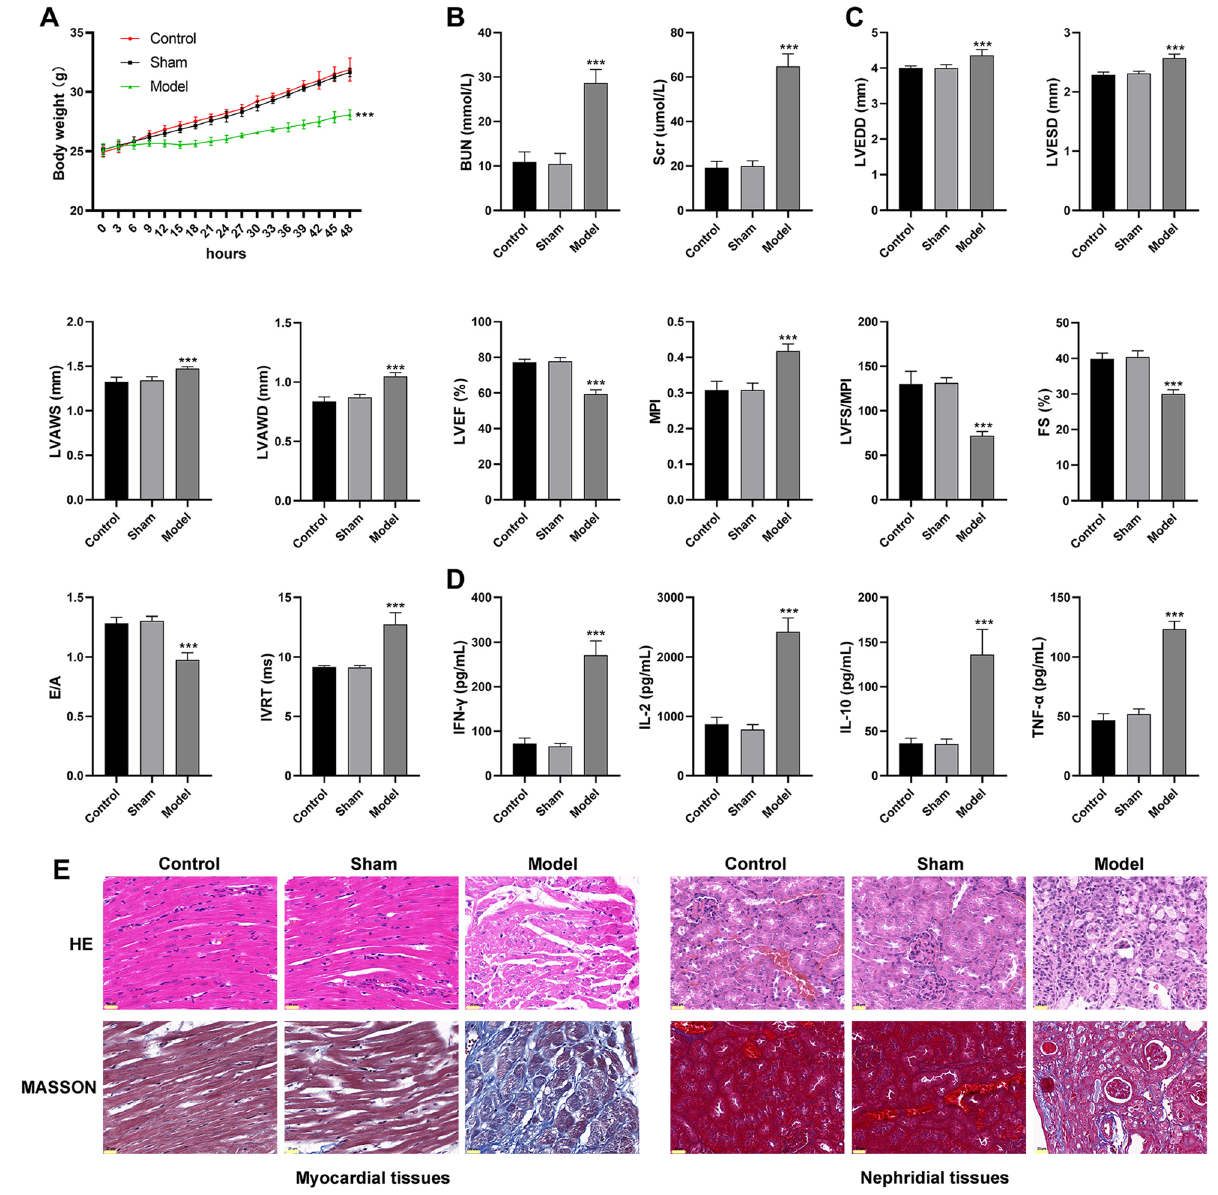
Figure 1. The characteristics of UC in the model mice ( A ) body weight; ( B ) serum levels of blood urea nitrogen (BUN) and serum creatinine (Scr); ( C ) cardiac parameters (left ventricular end-diastolic diameter (LVEDD), LV end-systolic diameter (LVESD), LV systolic anterior wall thickness (LVAWS), LV end-diastolic anterior wall thickness (LVAWD), LV ejection fraction (LVEF), myocardial performance index (MPI), LVEF/MPI, fractional shortening (FS), E- and A-waves (E/A), and isovolumic relaxation time (IVRT)); ( D ) serum levels of inflammatory parameters [interferon (IFN)-γ, interleukin (IL)-2, IL-10, and tumor necrosis factor (TNF)-α]; ( E ) HE and Masson staining of myocardial and nephridial tissues, scale bar = 20 μm. ***P < 0.001 vs. control. Data was analyzed using one-way analysis of variance (ANOVA) followed by Tukey’s